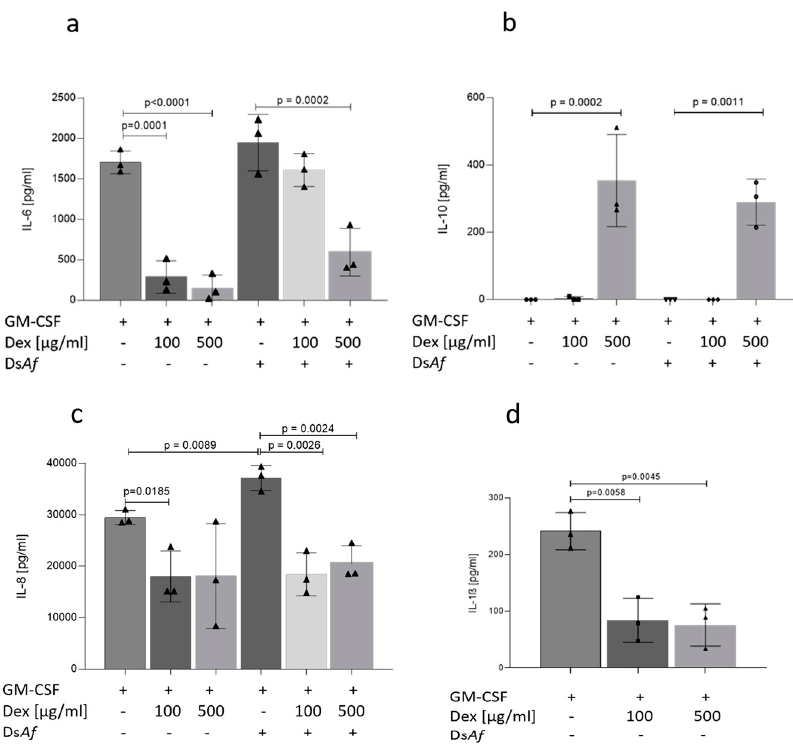
Figure 4. ( a – d ) Dexamethasone modifies cytokine levels towards anti-inflammatory in non- and A. fumigatus infected epithelial/immune lung tissues. Cell-free supernatants obtained from 24 h infected ( a – c ) versus uninfected ( a – d ), and 7 days Dex-treated versus untreated 3D lung models were analyzed for levels of secreted ( a ) IL-6, ( b ) IL-10, ( c ) IL-8, and ( d ) IL-1 β using ELISA. Results are representative of three independent experiments, and concentrations were expressed as mean ± SD. Significance was calculated using an unpaired Student’s t -test. Signs ( • , (cid:78) ) indicate numbers of independent repetition.